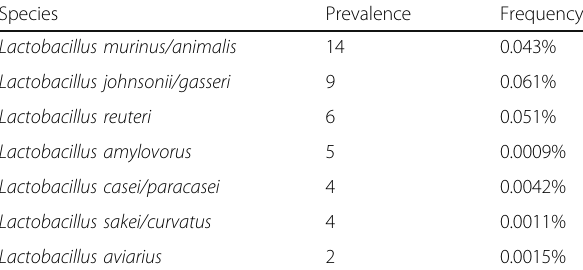
Table 2 The prevalence of the different Lactobacillus sequence variants and their overall frequencies (relative abundances) in the study population identified through 16S rRNA sequencing